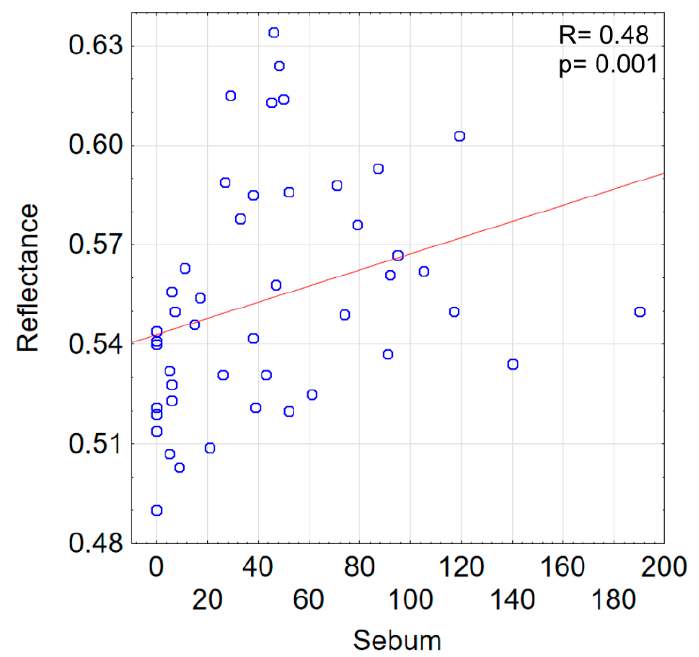
Figure 7. Correlation of sebum and skin reflectance at the wavelength 700–1100 nm. Red line—trend line.